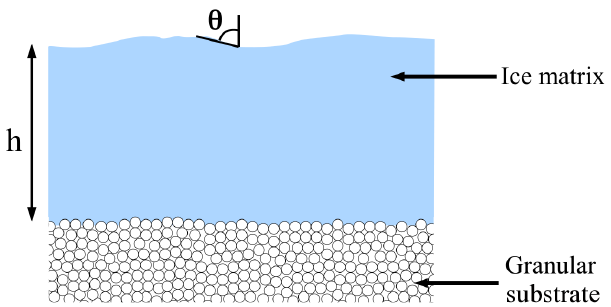
Figure 1. Scheme of the surface representation in the radiative transfer model applied to the laboratory measurements. h represents the slab thickness and ¯ θ represents the mean slope parameter used to describe the surface roughness.